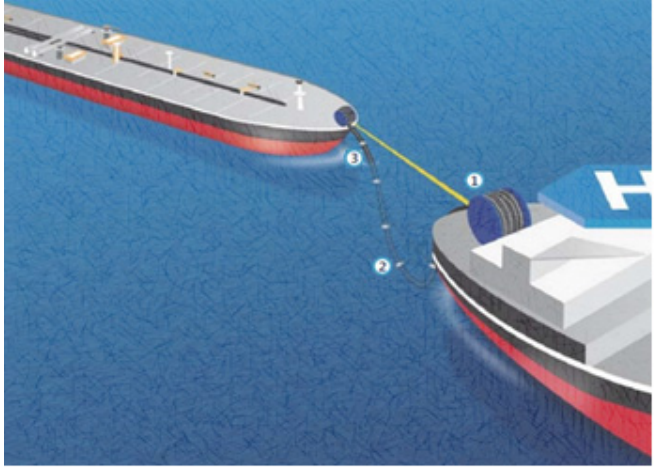
Figure 18. Tandem mooring reel catenary hose configuration.